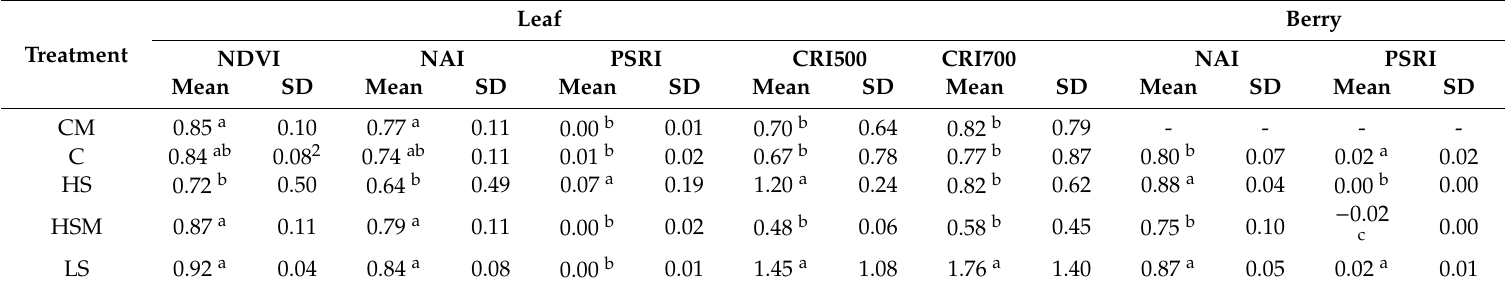
Table 3. Means and standard deviation (SD) of spectral indices calculated for leaves and berries. Leaf Treatment